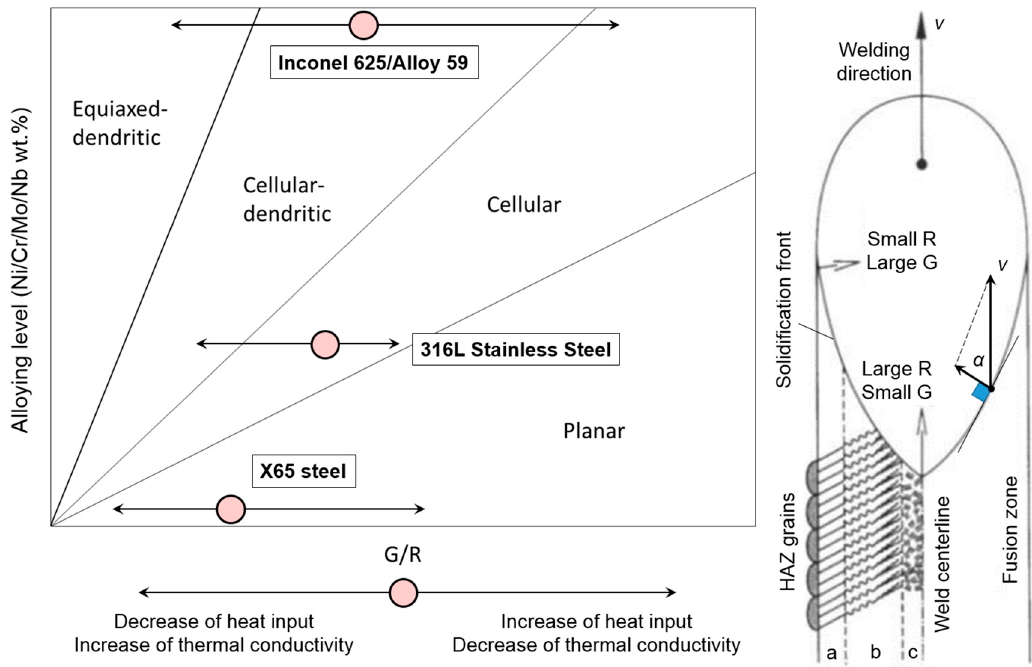
Figure 5. Schematic representation (modified from [34]) of the combined effect of crystal growth rate and melt temperature gradient on the weld metal solidification microstructure for different alloys; a—cellular, b—cellular-dendritic, and c—equiaxed-dendritic solidification mode. The product GR is related to the cooling rate ε (°C/s) as follows [36]: